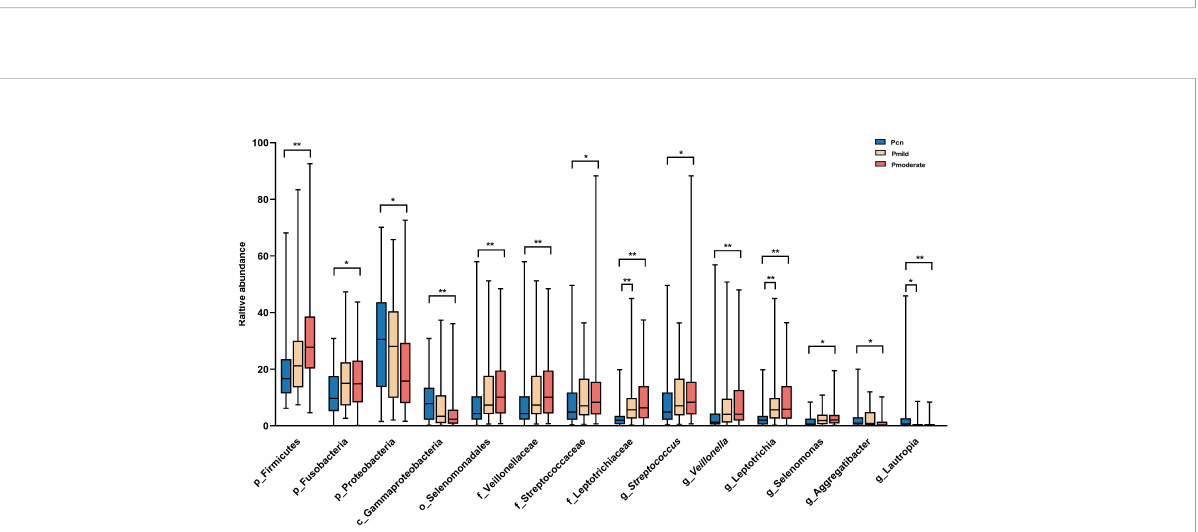
FIGURE 3 Alteration of oral predominant microbiotas among the three groups. Comparison among the three groups by Kruskal – Wallis-test analysis, and signi fi cant taxa classi fi cations obtained by Post Hoc test using Bonferroni adjustment. * p < 0.05, ** p <0.01; Pcn, subgingival plaque of normal cognition controls; Pmild, subgingival plaque of mild AD; Pmoderate, subgingival plaque of moderate AD; IQR, interquartile range.